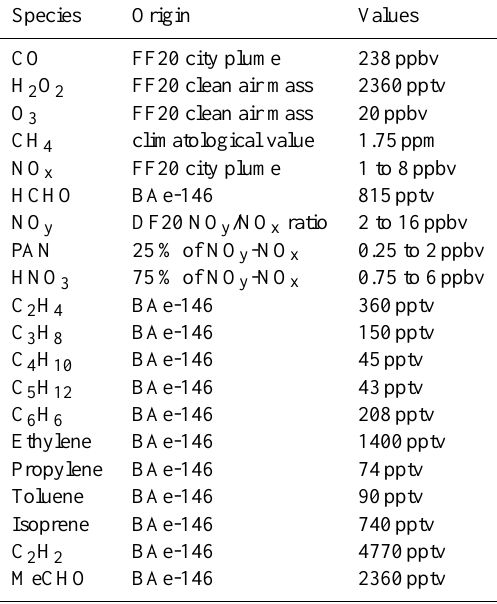
Table 4. Chemical initialisation of the box model reference run. Observations used to define the chosen concentrations are indicated. The BAe-146 VOC and CO measurements are average values